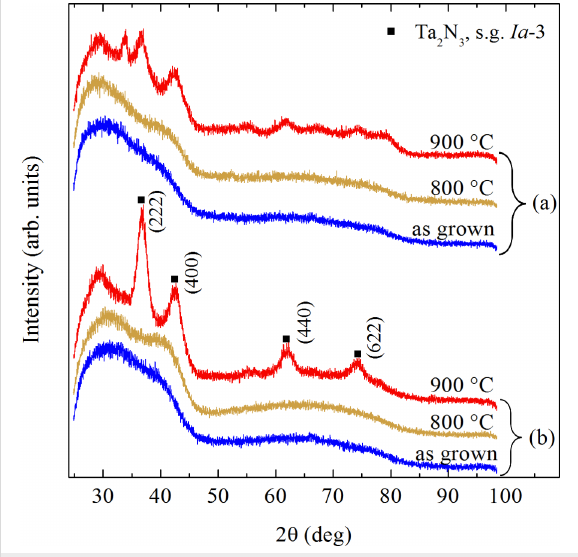
Figure 3: GIXRD curves of as-grown and annealed (Ta–N+Al 2 O 3 )/ Al 2 O 3 multilayers with two different nominal thicknesses of the metallic layers: (a) 4 nm and (b) 12 nm. The curves are vertically shifted for